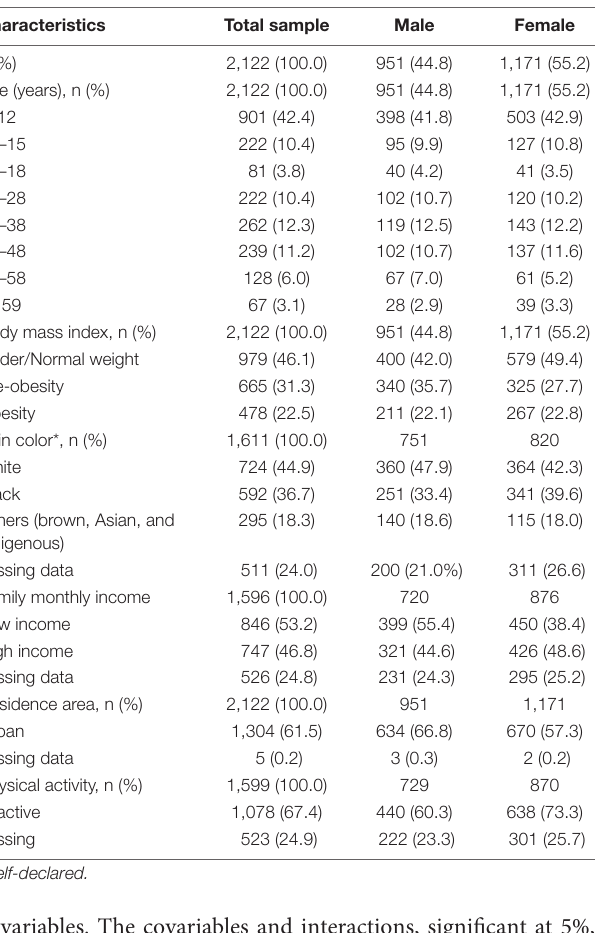
Frontiers in Nutrition |